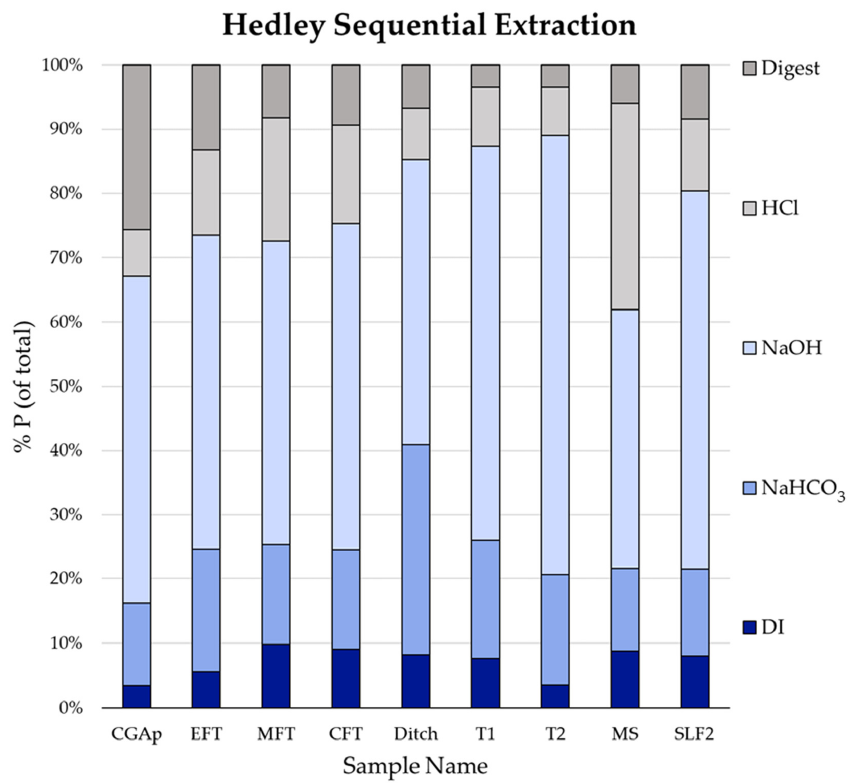
Figure 2. Phosphorus values from modified Hedley sequential extraction for composite soil samples collected throughout the Delmarva Peninsula. Hedley sequential extraction solution contributions from the different extractions (different colors) are shown as a percentage of the total P in the sample (each complete column). CGAp is a community garden soil; MS had a manure storage shed on it; SLF2 is an agricultural field on the same farm as MS; T1 and T2 are agricultural fields from a second farm; and CFT (center field transect), MFT (middle field transect), EFT (edge field transect), and Ditch are agricultural soil samples from a third farm along a